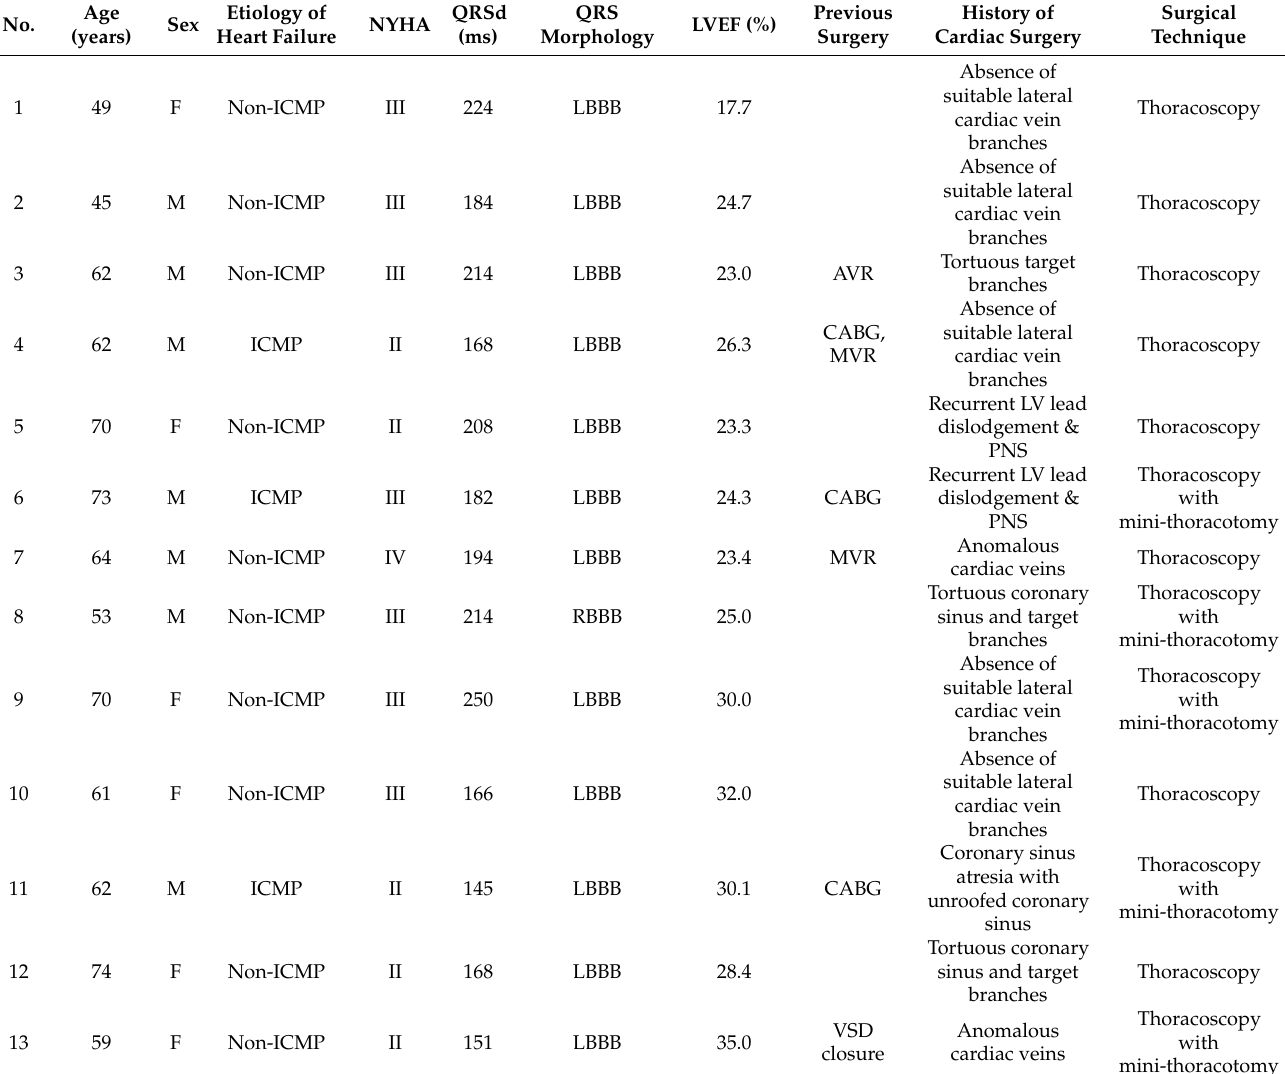
Table 1. Detailed information on patients with epicardial left ventricular